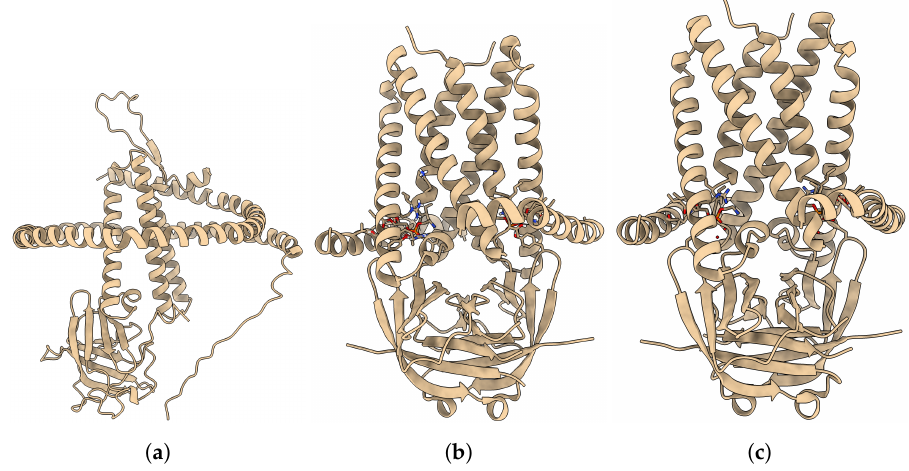
Figure A2. The target T203 is of EMD: 22898. ( a ) AlphaFold Predicted Structure. ( b ) DeepProLigand Predicted Structure. ( c ) PDB Deposited Structure with PDB ID: